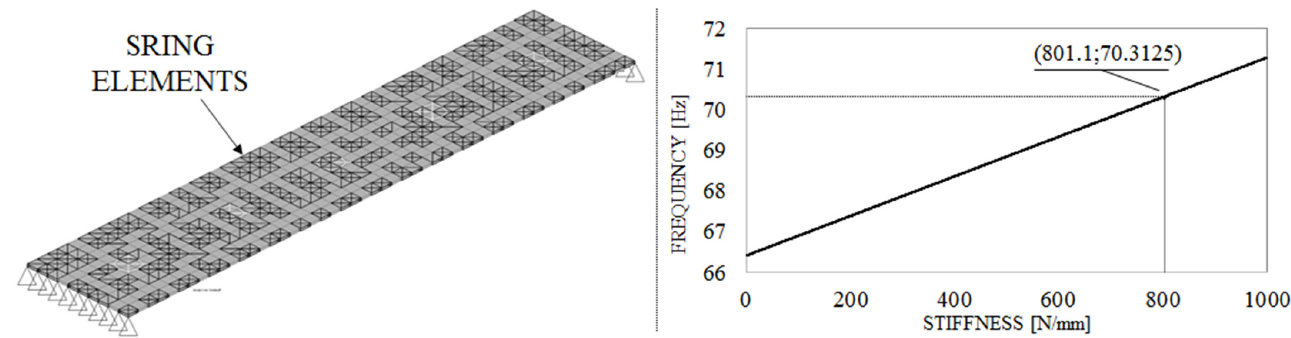
Figure 7. Adjusted linear FE reduced model ( left ) and spring element value interpolation ( right ).